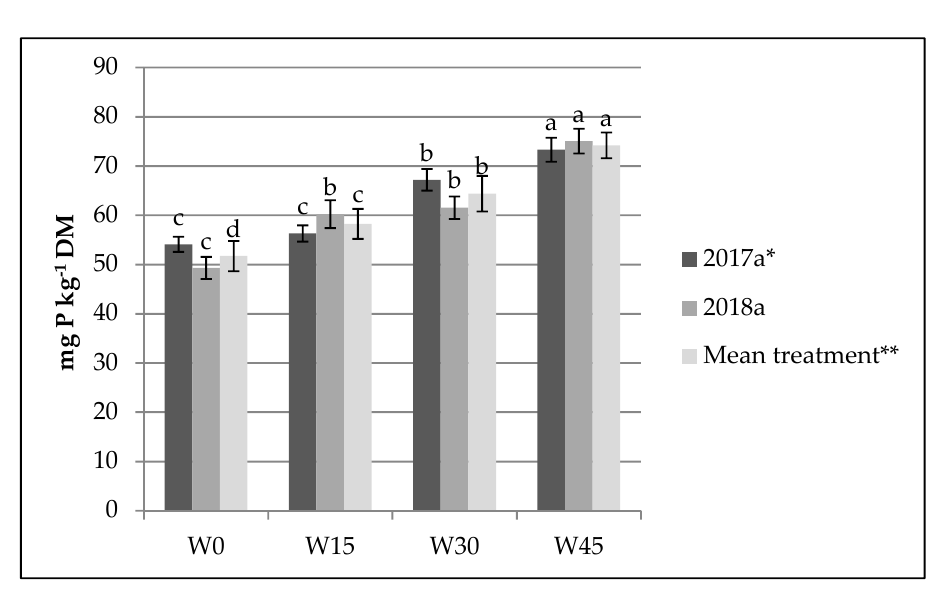
Figure 9. Available P content in soil. W0—the control with no stillage treatment, W15—15 m 3 of stillage per hectare, W30—30 m 3 of stillage per hectare, W45—45 m 3 of stillage per hectare. * means of years regardless of treatments; ** means of treatments regardless of years. The same letter means not significantly di ff erent.